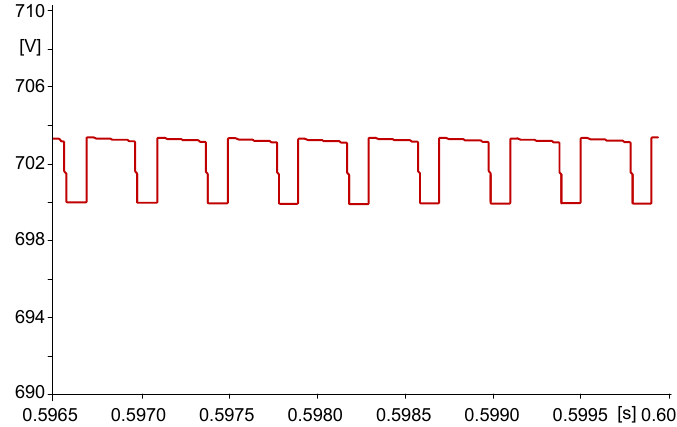
Figure 4. Variation of DC voltage for a cable with a length of 500 m, in proximity of the steady-state